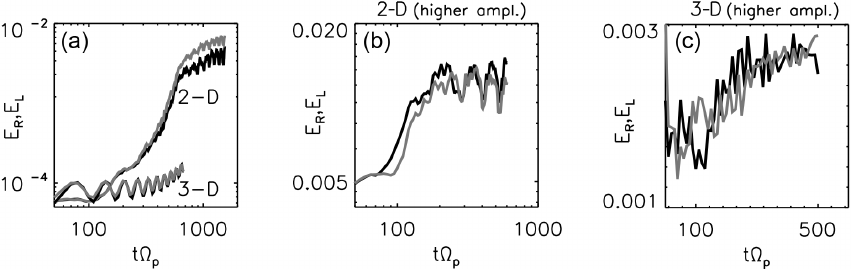
Figure 6. (a) Energy (normalized to the initial magnetic field energy) of the right-hand mode (black) and the left-hand mode (gray) of the magnetic field fluctuations calculated for the 2-D and 3-D setups using lower amplitudes of the initial pumping waves. (b) and (c) show results obtained from the 2-D and the 3-D setups using higher amplitudes of the initial pumping waves,